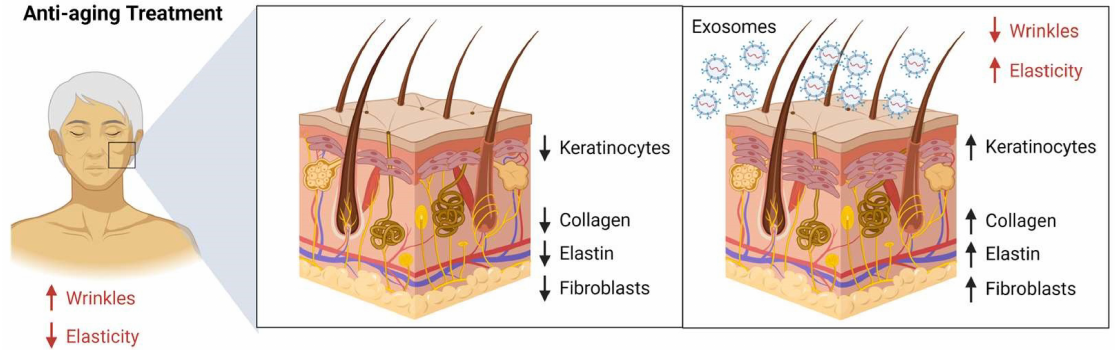
Figure 1. Role of exosomes for anti-aging treatment. The administration of ASC-CM and BMSC-exos had the e ff ect of decreasing the production of reactive oxygen species (ROS) to a low level, decreas- ing the expression of tumor necrosis factor-alpha (TNF- α ) but increasing the expression of trans- forming growth factor-beta (TGF- β ), leading to an increase in the production of matrix metallopro- teinase-1 (MMP-1) and pro-collagen type I, which ultimately enhanced the synthesis of collagen in the skin, improving its elasticity and reducing the appearance of wrinkles, making it an e ff ective anti-aging therapy. Figure was created using Biorender. 3. Role of Exosomes in Wound Healing Exosomes have been studied extensively in the context of wound healing, particu- larly in the context of burn wounds [14]. During injury, the cells release exosomes to help the wound heal. These immune cells help to clean the wound and reduce the risk of infec- tion. Exosomes also contain pro-in fl ammatory proteins that stimulate the release of cyto- kines and chemokines. These cytokines and chemokines initiate the recruitment of im- mune cells to the wound site and activate wound healing. In addition, exosomes contain growth factors that stimulate the growth of fi broblasts, which helps to close the wound [15]. Exosomes also promote cell-to-cell communication. They contain miRNAs that are proven to regulate gene expression in the cells around the wound [16]. This promotes the formation of new blood vessels, increasing the blood fl ow to the wound site. This in- creased blood fl ow then delivers oxygen and nutrients to the wound, which further speeds up the healing process [17]. Adipose-derived stem cells (ASCs) and their exosomes have been shown to have a therapeutic role in treating aberrant skin conditions, including wound healing, acne, and alopecia. ASC-exosomes have been shown to reduce in fl amma- tion and increase the production of extracellular matrix and growth factors, resulting in improved skin quality and healing (Figure 2). Overall, exosomes play an important role in wound healing.